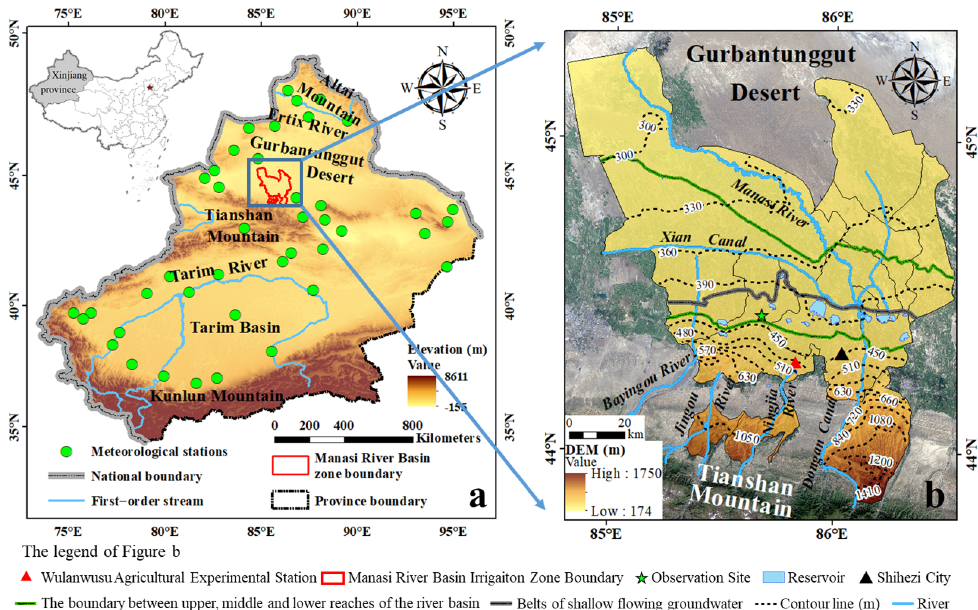
Figure 1. Location map of the study area (( a ). Location of the Manas River Basin and meteorological stations in Xinjiang; ( b ). Map of the Manas River Basin).